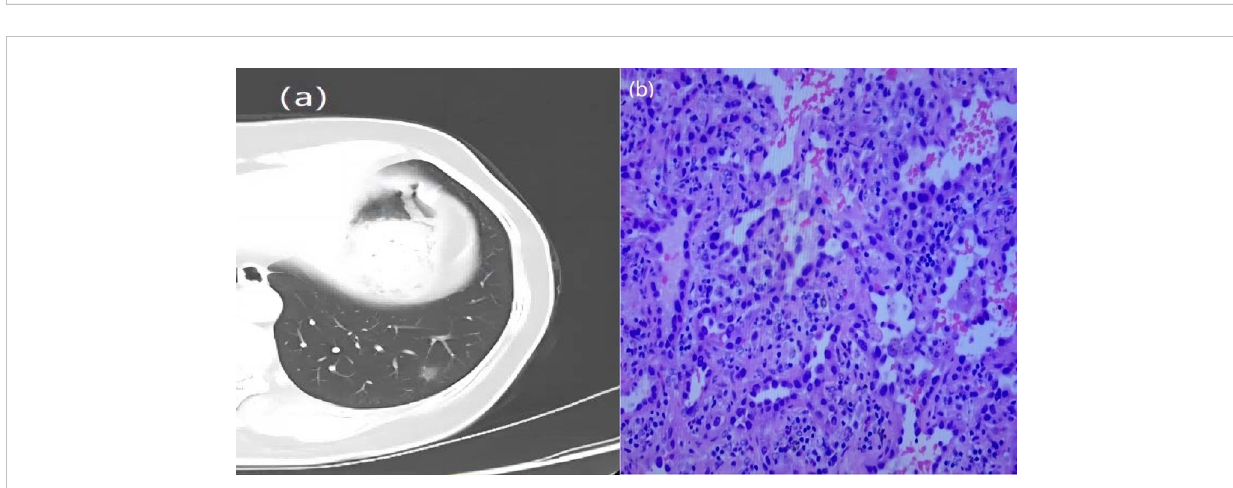
FIGURE 3 A 57-year-old woman with a GGN. CT showed lobulation and burr. (A) Chest scan. (B) pathologically con fi rmed for MIA.